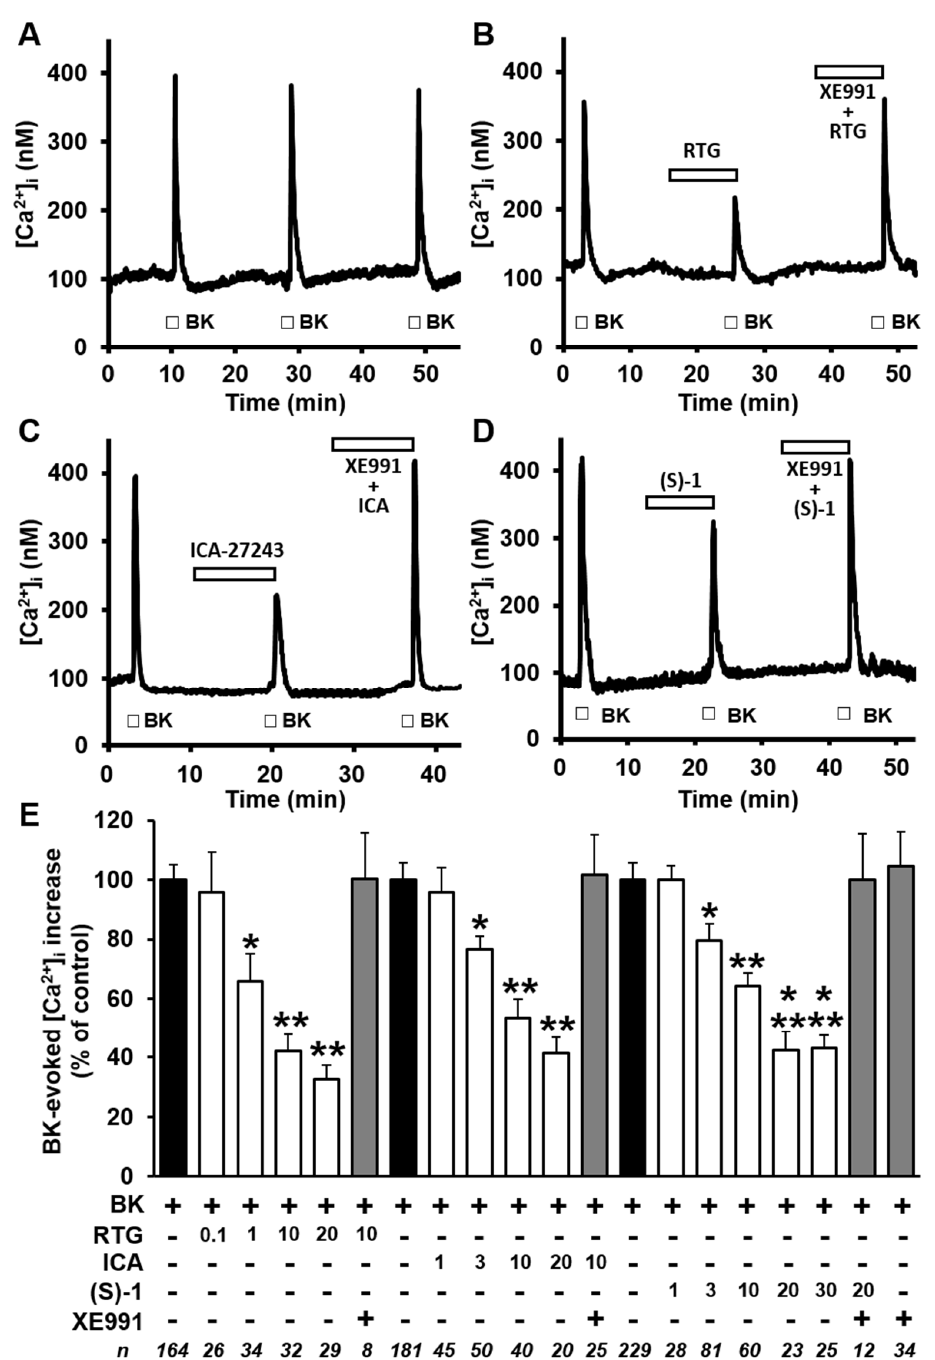
Figure 2. Effects of Kv7 modulators on bradykinin (BK)-induced [Ca 2+ ] i responses in differentiated F11 cells. ( A , B , C , D ) Representative traces showing the effect of three subsequent exposures to BK (250 nM) on [Ca 2+ ] i in differentiated F11 cells in control conditions ( A ) or after exposure to 10 μM of the indicated drugs ( B – D ). The length of the bars indicates the duration of each drug exposure. ( E ) Quantification of the effects of the indicated drugs (whose concentrations are reported in μM at the bottom of the panel) on the BK-induced [Ca 2+ ] i responses. Data are expressed as percent of [Ca 2+ ] i increase prompted by the first BK exposure. Each bar is the mean ± SEM of separate determinations (indicated as n values at the bottom of the panel) performed in at least three experimental sessions. *, **, or *** = p < 0.05 versus the immediately lower concentrations tested of the same drug.